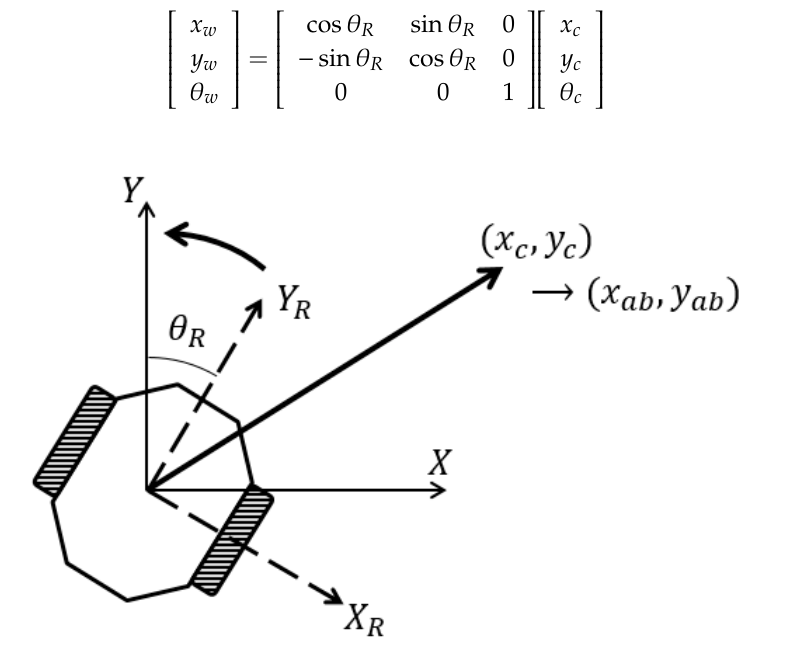
Figure 4. Rotation of the collision vector.